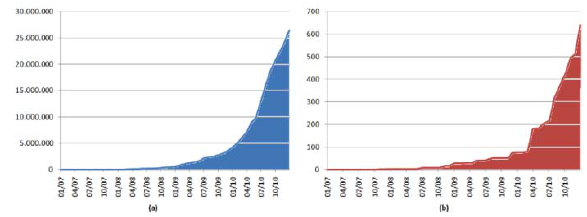
Figure 37: Increase in use of the “building” (blue) and the “indoor” key for OSM additions from 2007 up to 2011. From Goetz and Zipf (2011).